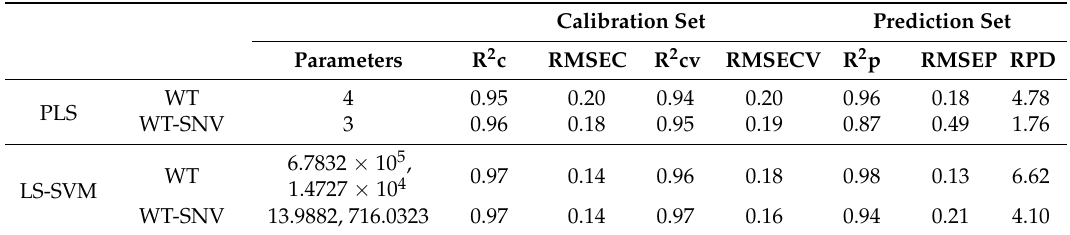
Table 3. Prediction results of total flavonoids content in Chrysanthemum morifolium